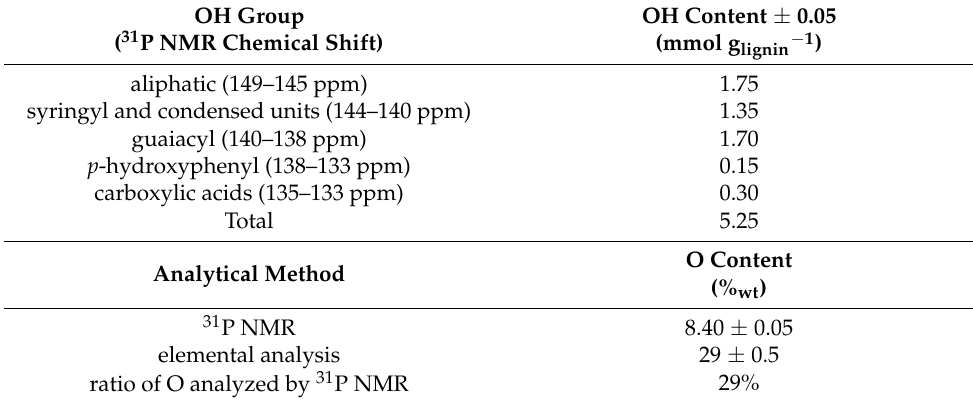
Table 2. Quantitative data concerning OH groups in the initial lignin, obtained by derivatization with TMDP and classified by nature (see Figure S3). Comparison with elemental analysis